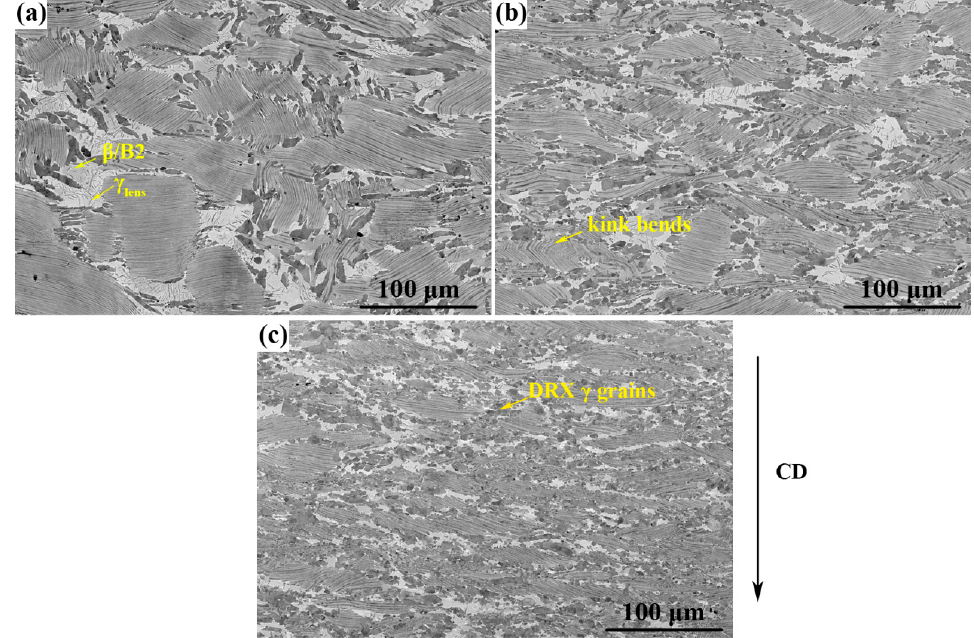
Figure 4. SEM images of Ti-44Al-4Nb-1.5Cr-0.5Mo-0.2B alloy compressed at 1473 K and a strain rate of 0.01 s − 1 : ( a ) 20% reduction; ( b ) 40% reduction; and ( c ) 60% reduction. CD denotes the compressive direction, and in all images, the compressive direction is vertical.